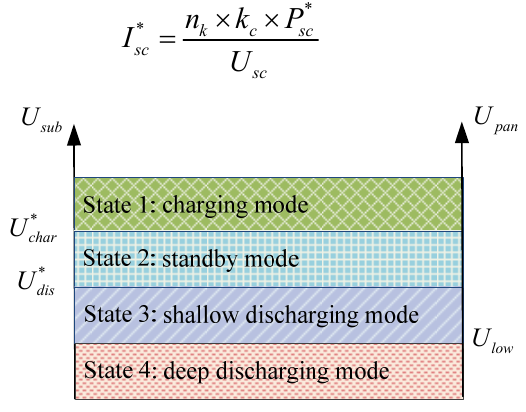
Figure 10. Work states of super-capacitor